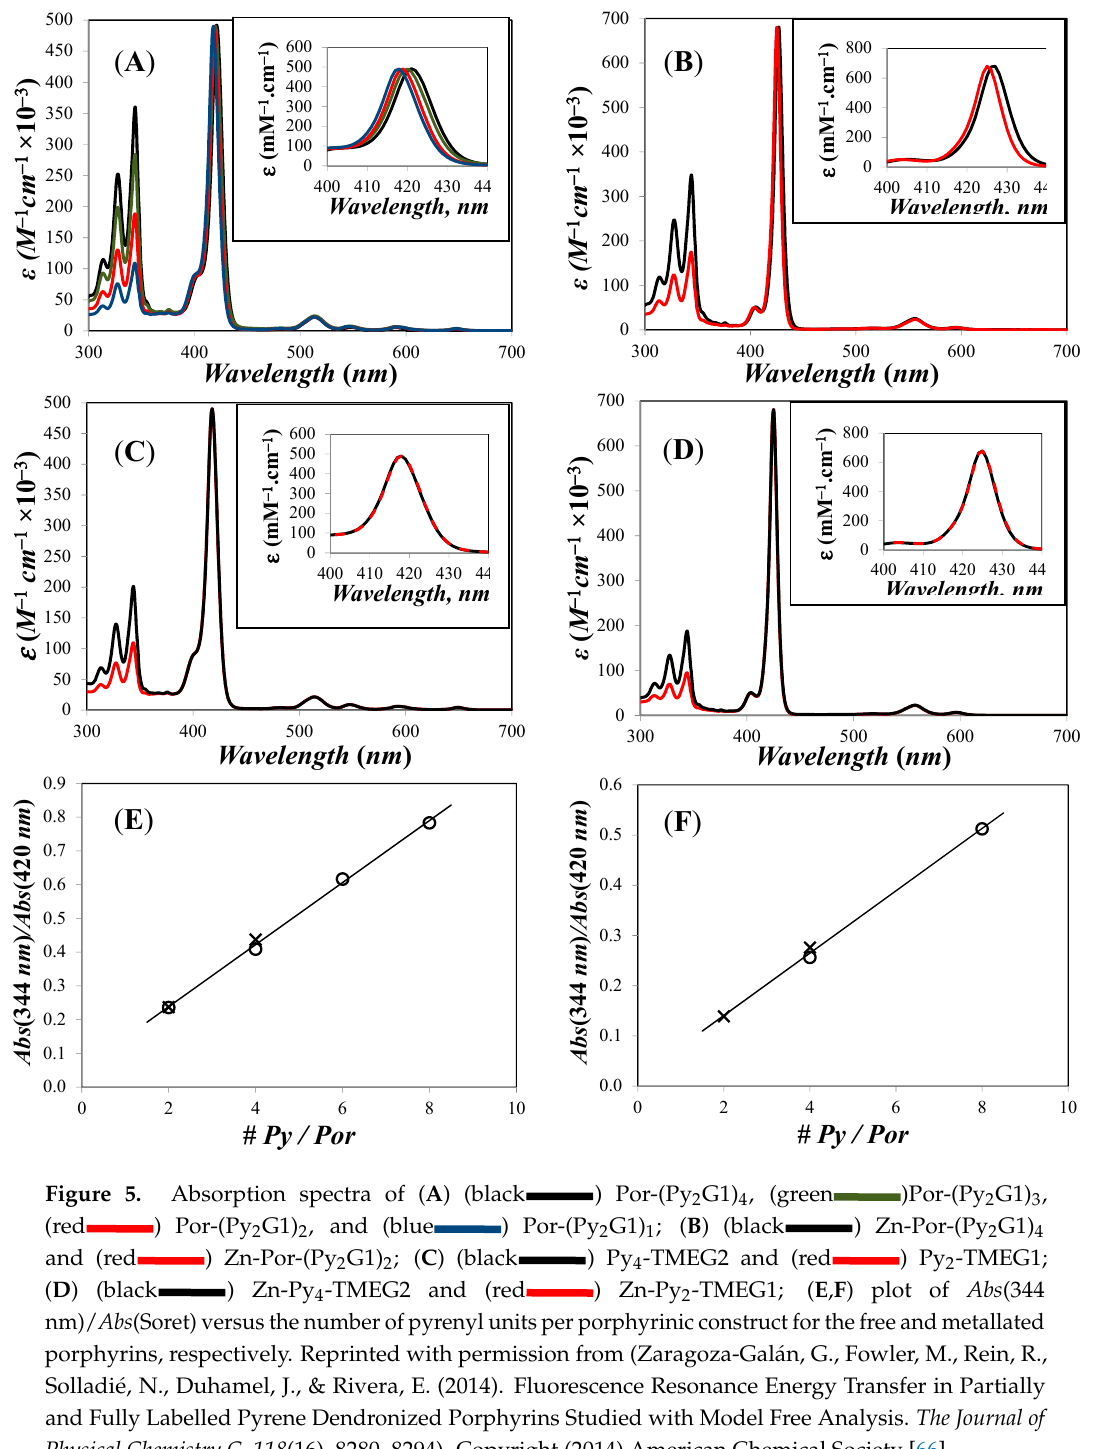
Figure 5. Absorption spectra of ( A ) (black ) Por-(Py 2 G1) 4 , (green )Por-(Py 2 G1) 3 , (red ) Por-(Py 2 G1) 2 , and (blue ) Por-(Py 2 G1) 1 ; ( B ) (black ) Zn-Por-(Py 2 G1) 4 and (red ) Zn-Por-(Py 2 G1) 2 ; ( C ) (black ) Py 4 -TMEG2 and (red ) Py 2 -TMEG1; ( D ) (black ) Zn-Py 4 -TMEG2 and (red ) Zn-Py 2 -TMEG1; ( E , F ) plot of Abs (344 nm)/ Abs (Soret) versus the number of pyrenyl units per porphyrinic construct for the free and metallated porphyrins, respectively. Reprinted with permission from (Zaragoza-Galán, G., Fowler, M., Rein, R., Solladié, N., Duhamel, J., & Rivera, E. (2014). Fluorescence Resonance Energy Transfer in Partially and Fully Labelled Pyrene Dendronized Porphyrins Studied with Model Free Analysis. The Journal of Physical Chemistry C , 118 (16), 8280–8294). Copyright (2014) American Chemical Society [66]. A slight shift of the absorption band of the porphyrin moiety was observed in the series of the porphyrinic dendrimers in function of the amount of mesityl groups present in the construct. The Soret band of the free porphyrins shifted from 421 to 420, 419, and 418 nm when going from Por-(Py 2 G1) 4 to Por-(Py 2 G1) 3 , Por-(Py 2 G1) 2 , and Por-(Py 2 G1). Likewise, the Soret band of the metalated porphyrins shifted from 427 to 425 nm when going from Zn-Por-(Py 2 G1) 4 to Zn-Por-(Py 2 G1) 2 .